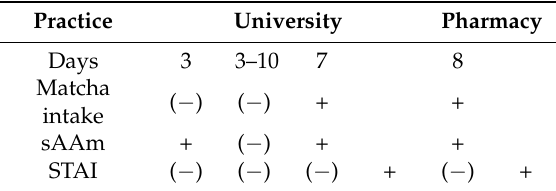
Table 1. Experimental